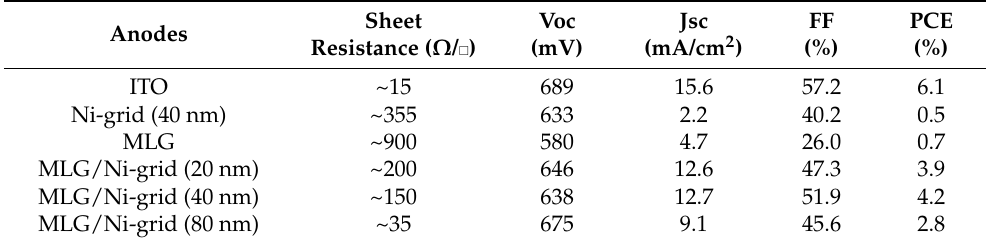
Table 1. Photovoltaic parameters of BHJ solar cells in direct configuration on glass-ITO (reference), MLG/Ni-grid with different thicknesses, pristine Ni-grid and MLG only as anodes, fabricated in the same batch with 0.1 cm 2 of active